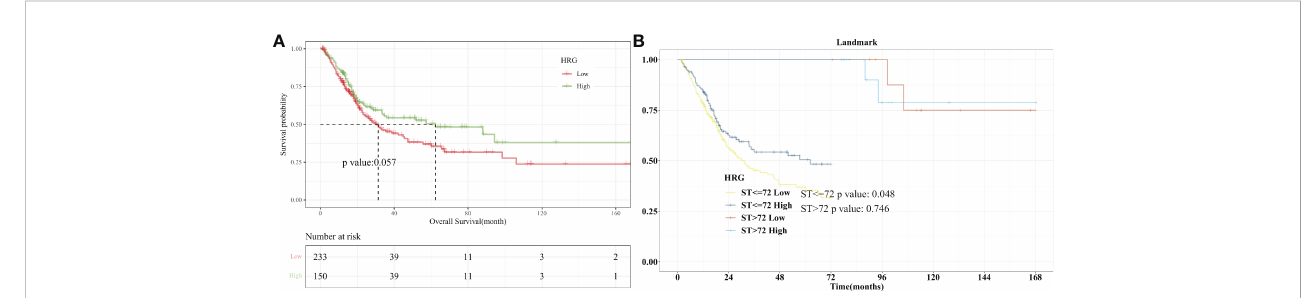
FIGURE 2 Survival Analysis with HRG expression in BLCA. (A) . Kaplan-Meier curve showed that HRG expression had a critical level of statistical signi fi cance with OS (P =0.057); (B) . With 72 months after diagnosis as Landmark, higher HRG was associated with improved patient survival at an early stage